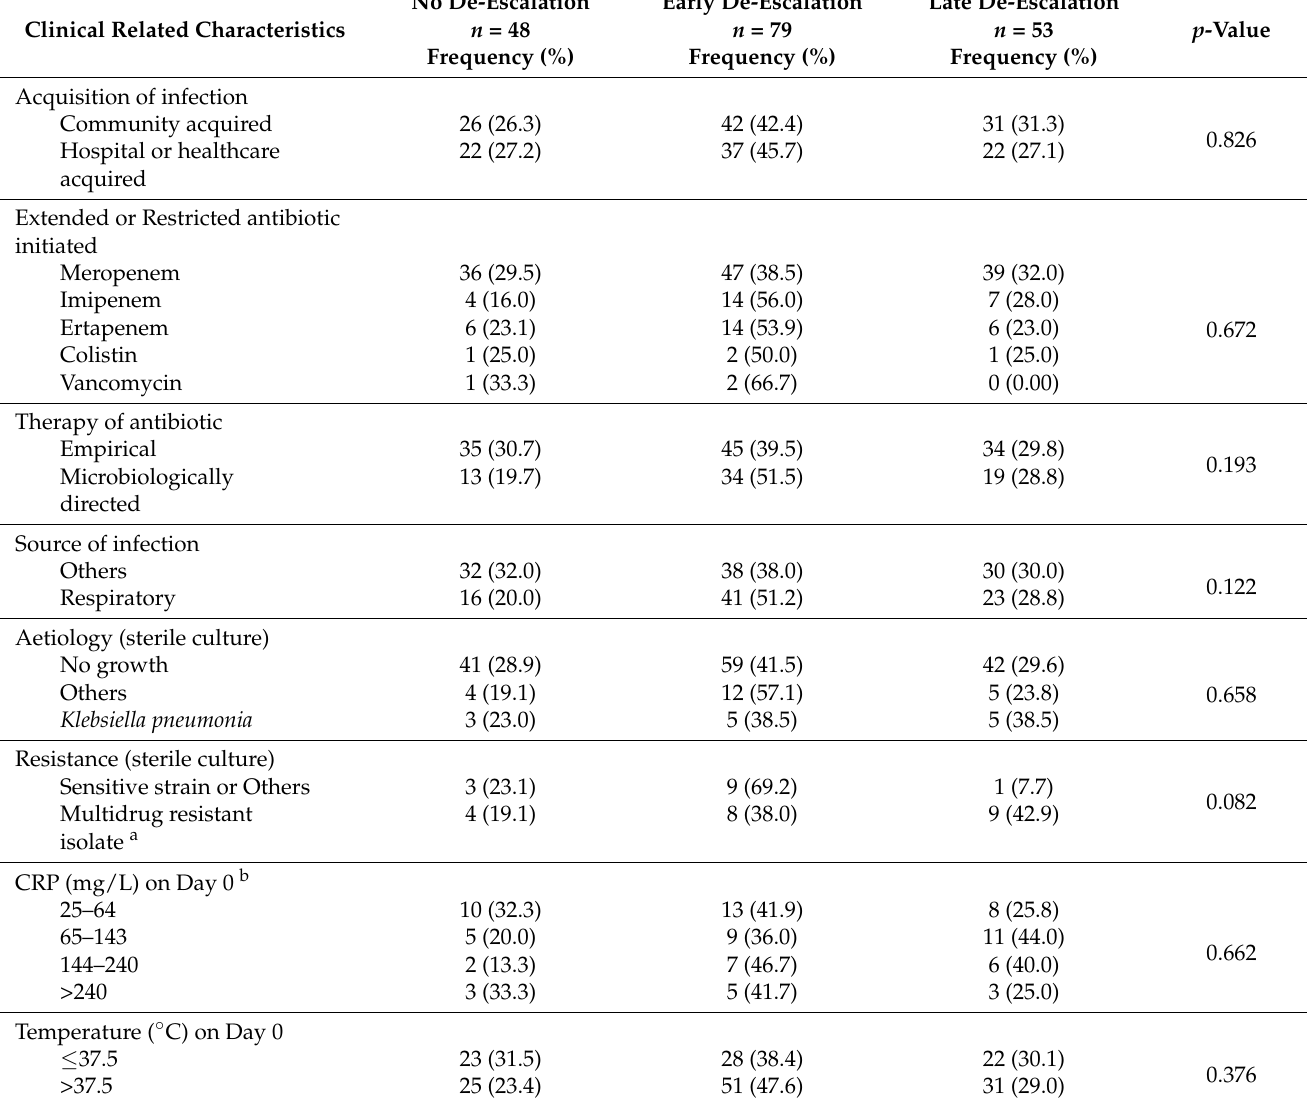
Table 2. Frequency distribution of clinical related characteristics based on de-escalation